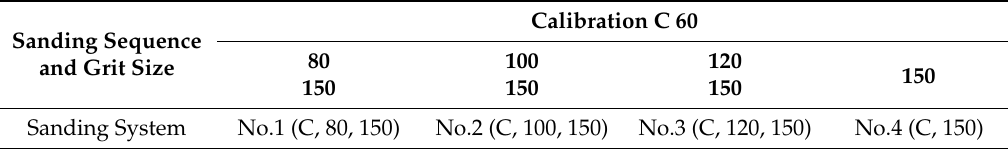
Table 1. Design of wood surface preparation by parallel